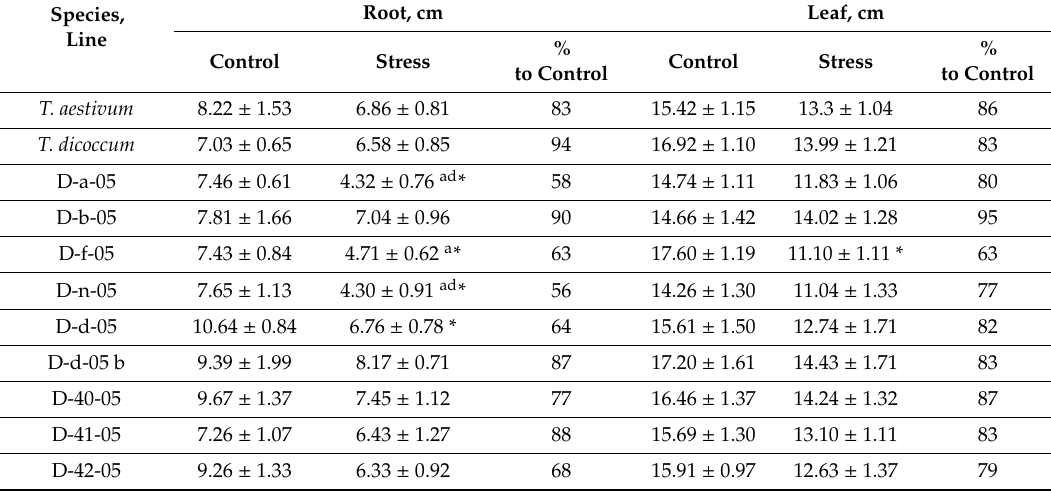
Table 1. Growth parameters of the first leaf and primary roots of seedlings of alloplasmic wheat lines and their parental forms under drought conditions (17.6% sucrose, 72 h) (means ± standard deviations). Root, cm Leaf, cm Species, Line % % Control Stress Control Stress to Control to Control T. aestivum 8.22 ± 1.53 6.86 ± 0.81 83 15.42 ± 1.15 T.